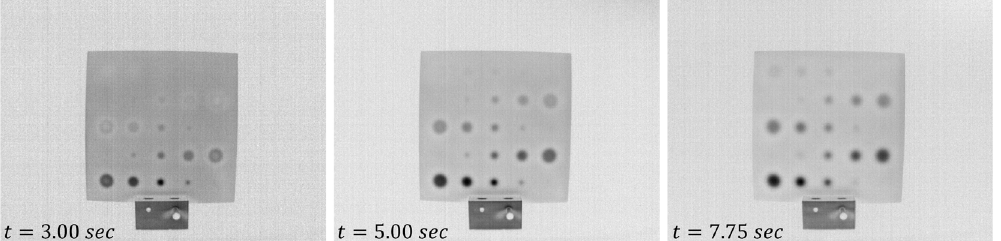
Figure 8. TSR first derivative images at 3.00, 5.00 and 7.75 seconds after heating.